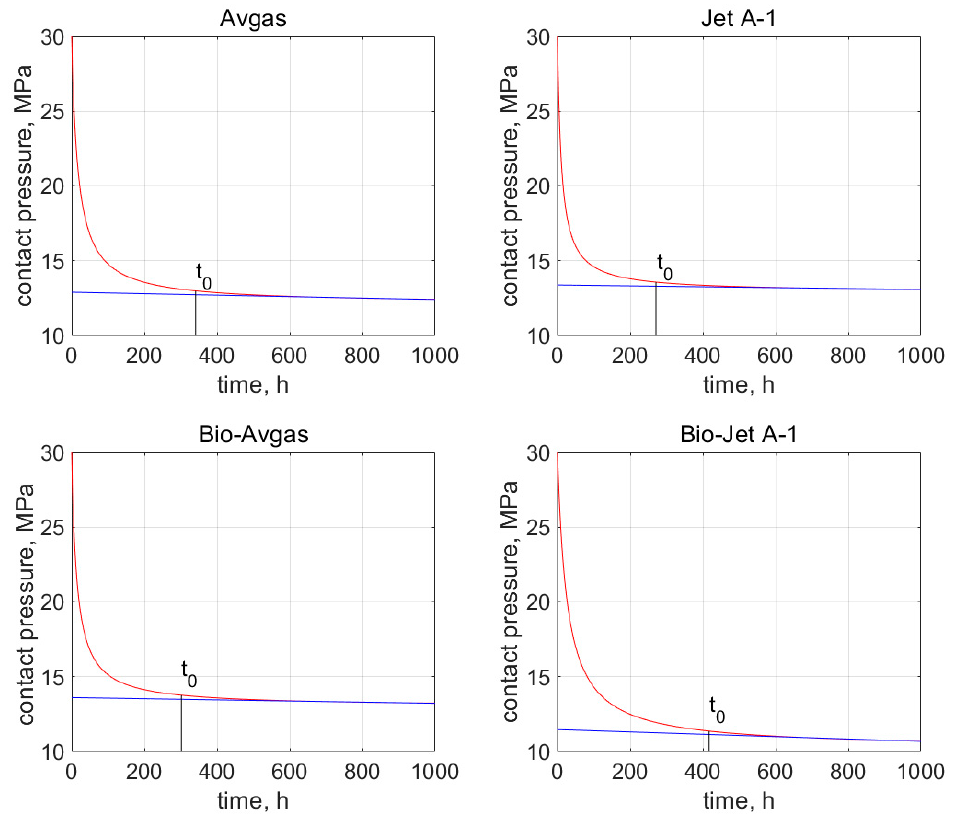
Figure 7. Time t 0 from when the secondary creep starts, which is marked in the contact pressure graph (red curve) for the AFO gasket and all the tested fuels. The blue line indicates the linear decrease of constant pressure.